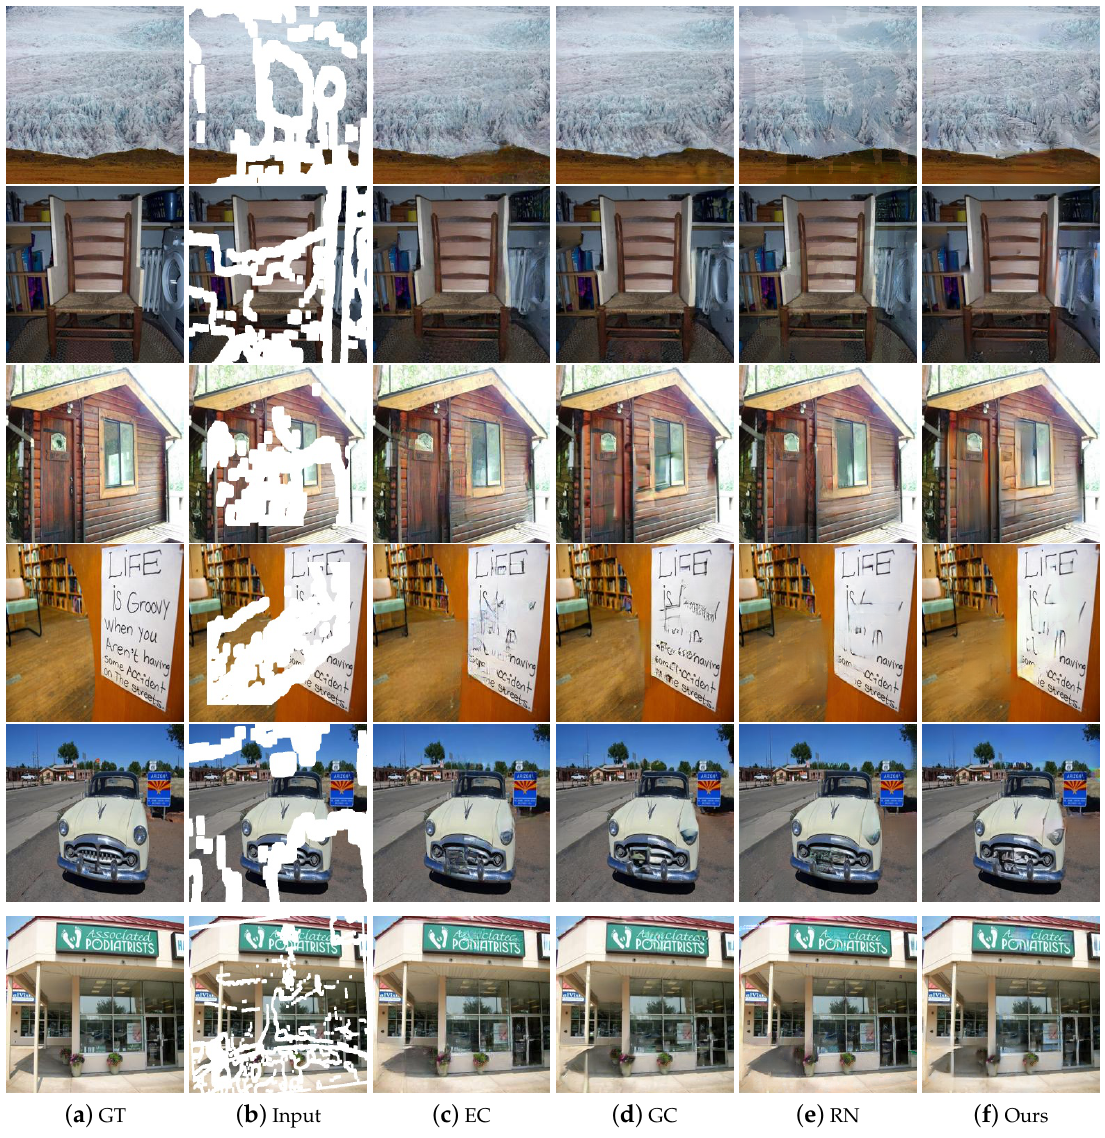
Figure 7. Qualitative comparisons of different methods on Places2 [27] with irregular